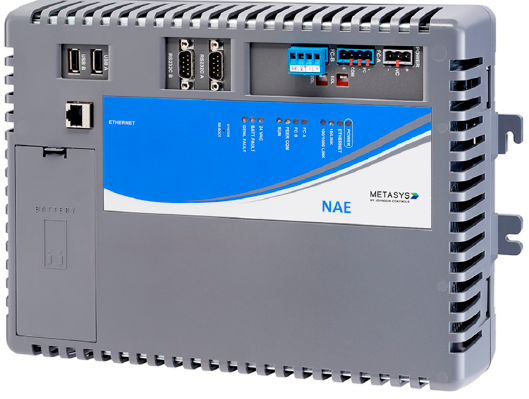
Figure 5. NAE55 Network Automation Engine.